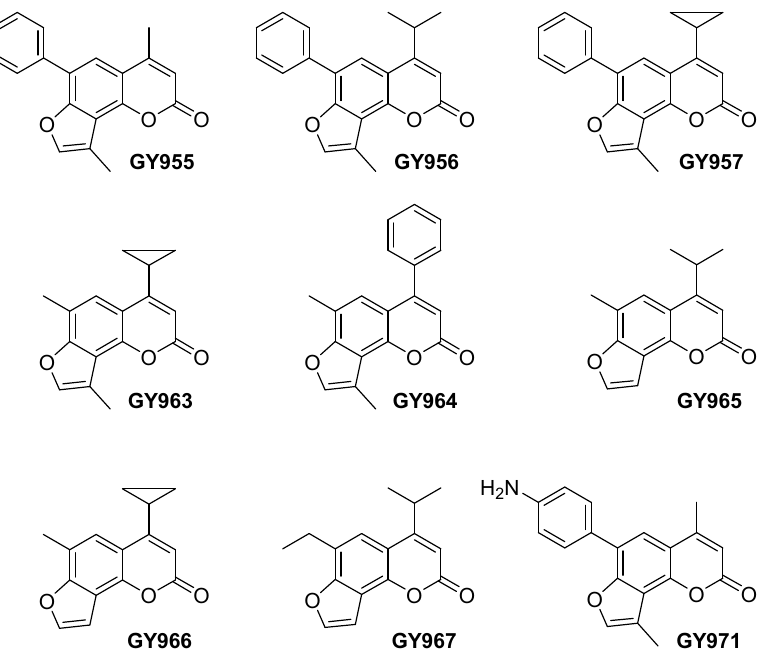
Figure 2. Chemical structures of the selected TMA analogues.